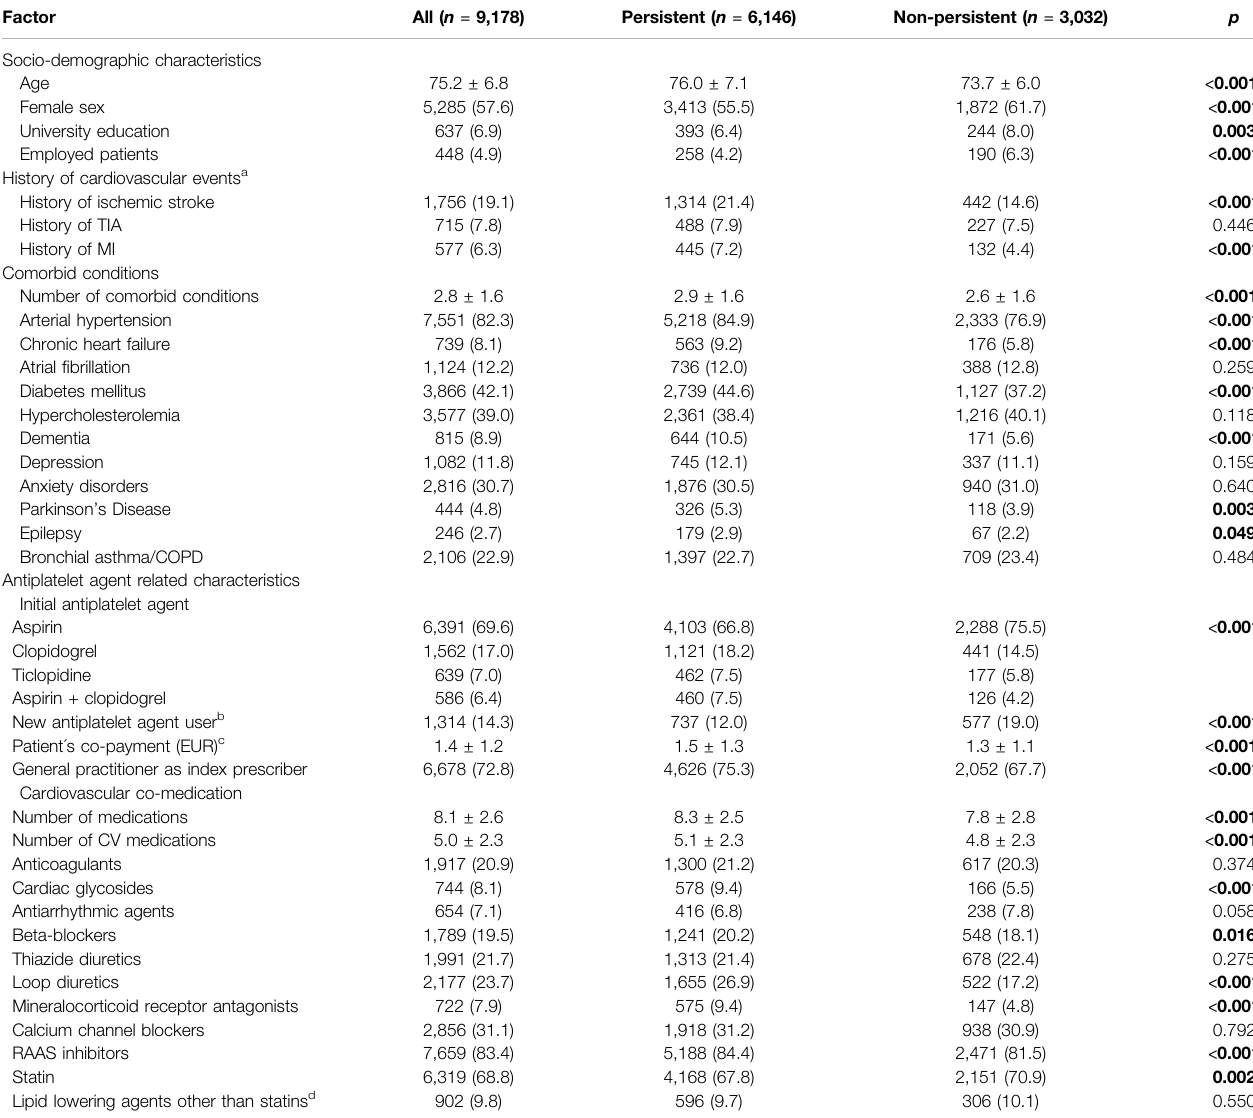
TABLE 1 | Baseline characteristics of the study cohort.